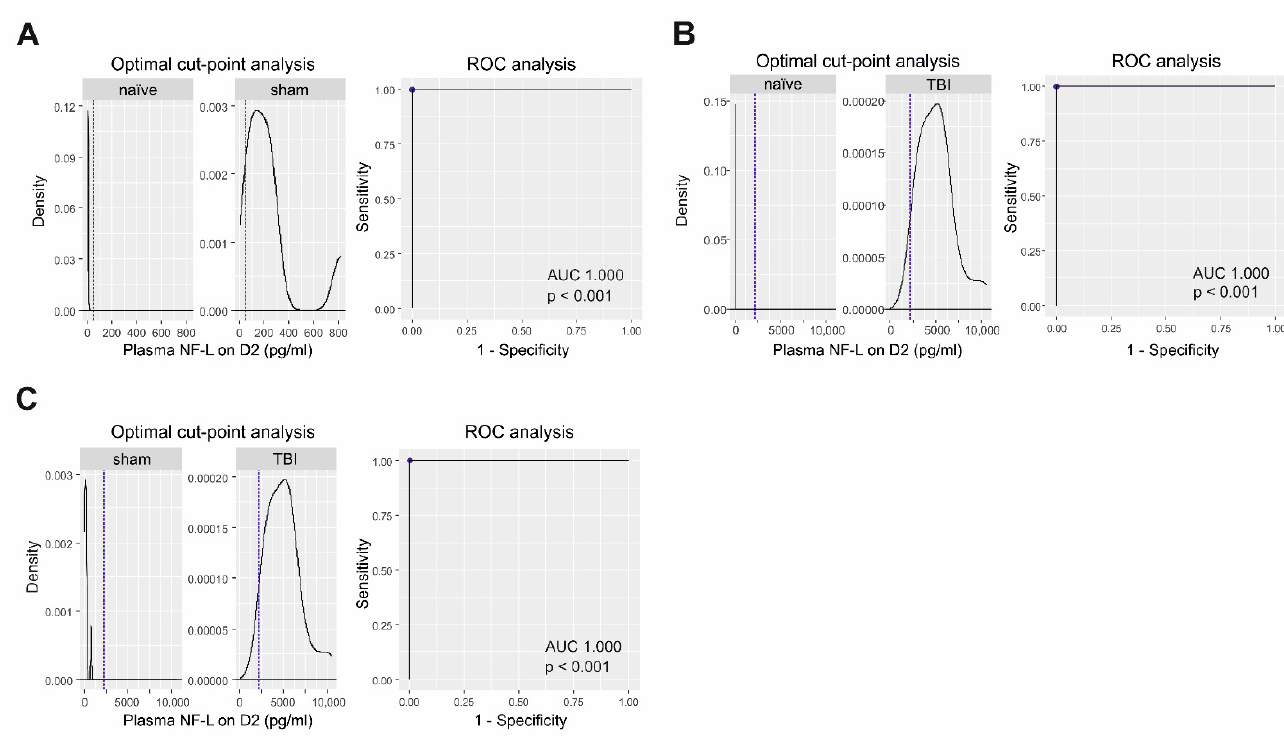
Figure 3. Plasma NF-L as a diagnostic biomarker for sham operation and TBI. ( A ) ROC analysis indicated that NF-L levels on D2 distinguished sham-operated rats (n = 8) from the naïve condition (baseline samples, n = 34) with 100% sensitivity and 100% specificity (AUC 1.0, p < 0.001, cut-off 49 pg/mL (dashed line)]. ( B ) NF-L levels on D2 distinguished TBI rats (n = 26) from the naïve condition (n = 34) with 100% sensitivity and 100% specificity (AUC 1.0, p < 0.001, cut-off: 2201 pg/mL). ( C ) NF-L levels on D2 distinguished TBI (n = 13) and sham-operated rats (n = 13) with 100% sensitivity and 100% specificity (AUC 1.0, p < 0.001, cut-off: 2201 pg/mL). Abbreviations: AUC, area under the curve; BL, baseline; D2, day 2 post-TBI, NF-L, neurofilament light chain; ROC, receiver operating characteristics; TBI, traumatic brain injury.